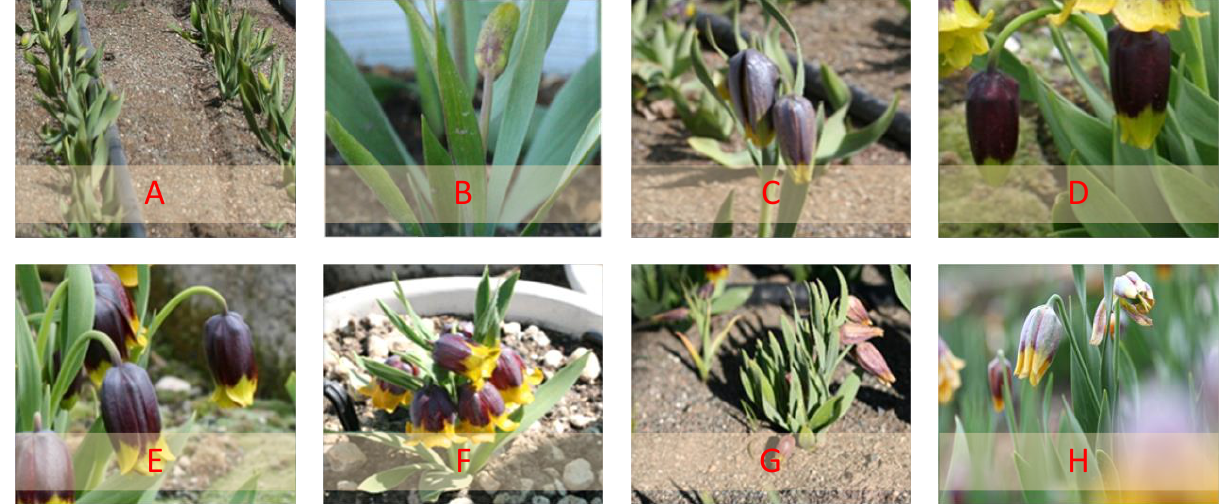
Figure 1. Flowering dynamics; ( A ). bud burst, ( B ). flowering initial, ( C ). pre-dehiscence phase, ( D ). first dehiscence phase, ( E ). full dehiscence, ( F ). end-dehiscence phase, ( G ). fresh perianth phase and ( H ). perianth wilting phase. (original photo by M. Aslay).